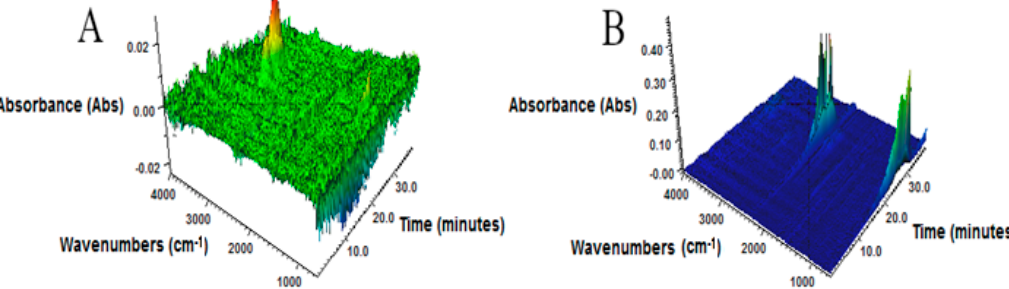
Figure 4. 3D FTIR plots for volatile products emitted during the thermal decomposition of GTR: ( A ) nitrogen, ( B ) air atmosphere (heating ramp of 20